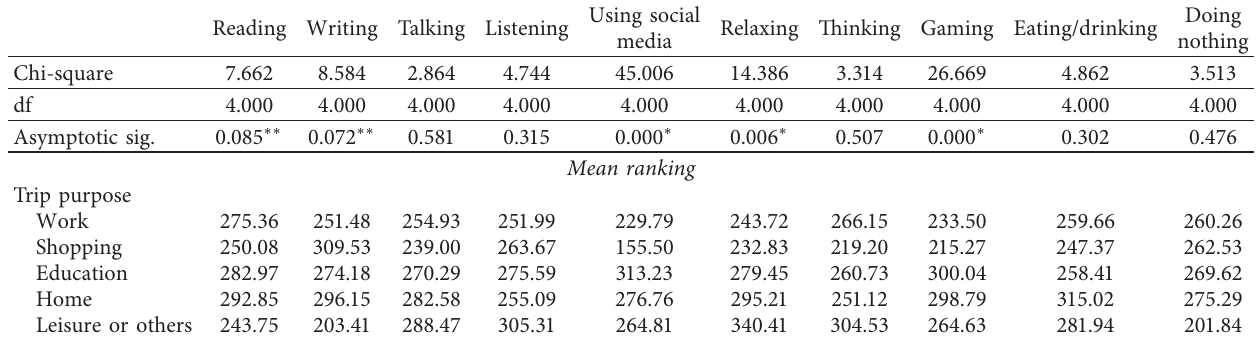
Table 14: Kruskal–Wallis test statistics and the rankings of trip purpose